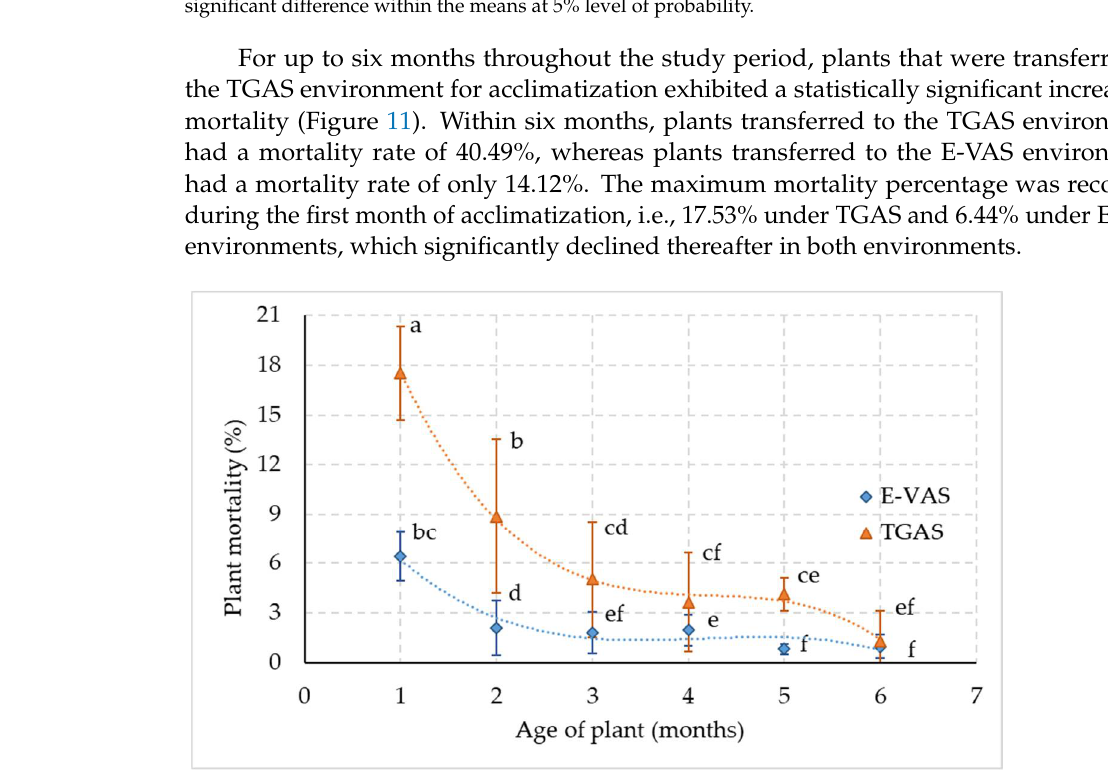
Figure 11. Plant mortality response of tissue culture-derived date palm (cv. Khalas) plants acclimatized under the designed ex vitro acclimatization system (E-VAS) and traditional greenhouse acclimatization system (TGAS) environments. The mortality percentage was calculated after one month period until six months. Y-bars indicate the standard deviation within the sample. Different letters indicate significant differences under E-VAS and TGAS environments. Paired Student t-test was applied on mean data of mortality percentage and the probability value was 0.02.